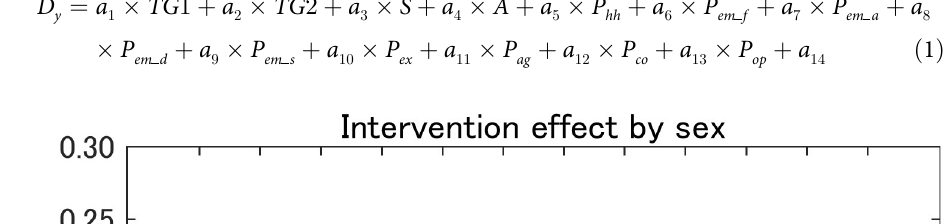
To quantify the DID effects of TG2 messages, we devised the two linear regression models in Eqs (1) and (2) considering sample attributes and personality traits. The personality attributes were sampled using the short Japanese version of the HEXACO model [41, 42], which is an extended version of Big Five model [43].